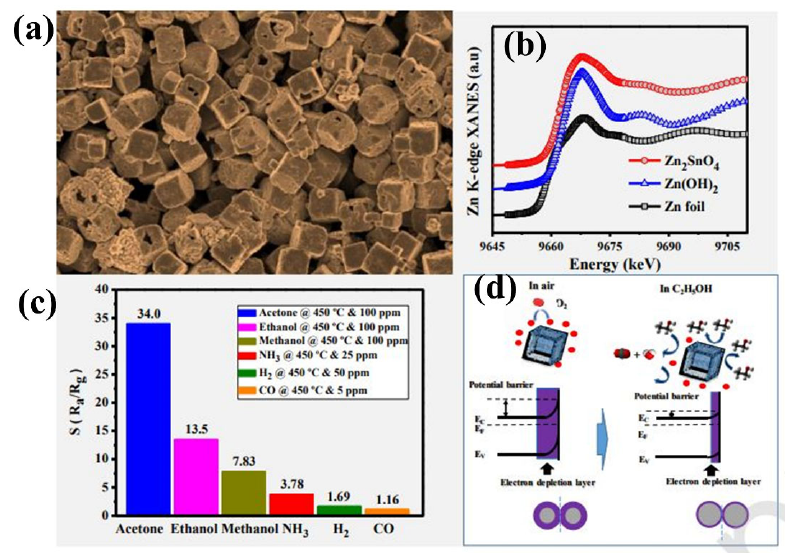
Figure 6. Zn 2 SO 4 hollow cubic assembled for lung cancer VOC biomarker ( a ) Zn 2 SO 4 SEM image, ( b ) first derivative XANES Spectra of Zn 2 SO 4 , ( c ) Selectivity, ( d ) Gas sensing mechanism. Reprinted with permission from [95] Copyright 2020 Elsevier.